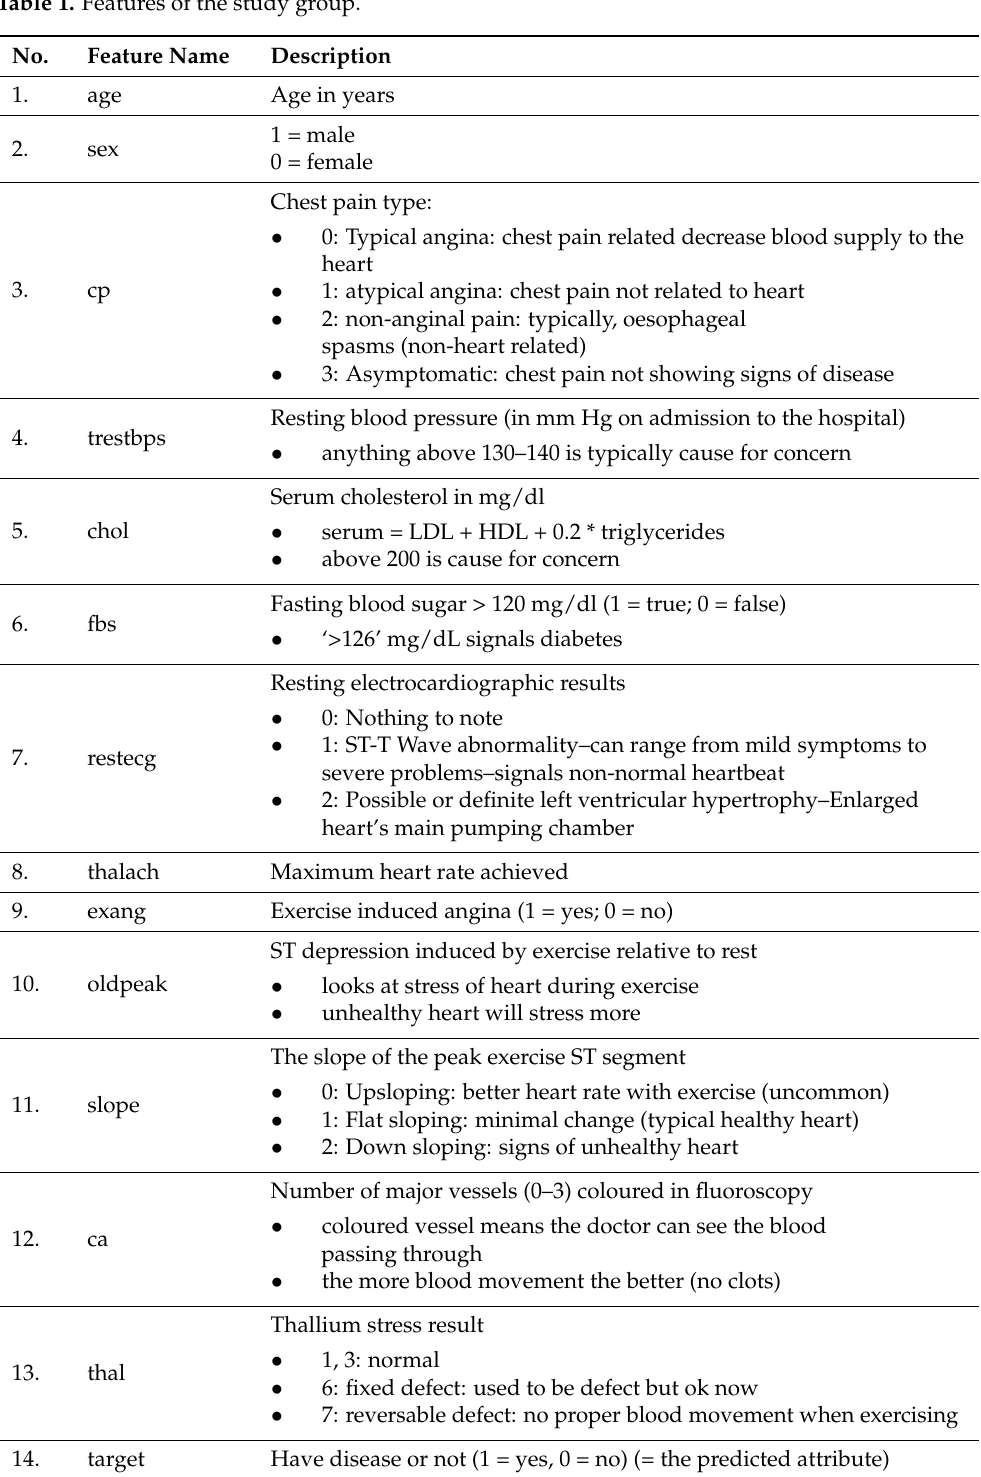
Table 1. Features of the study